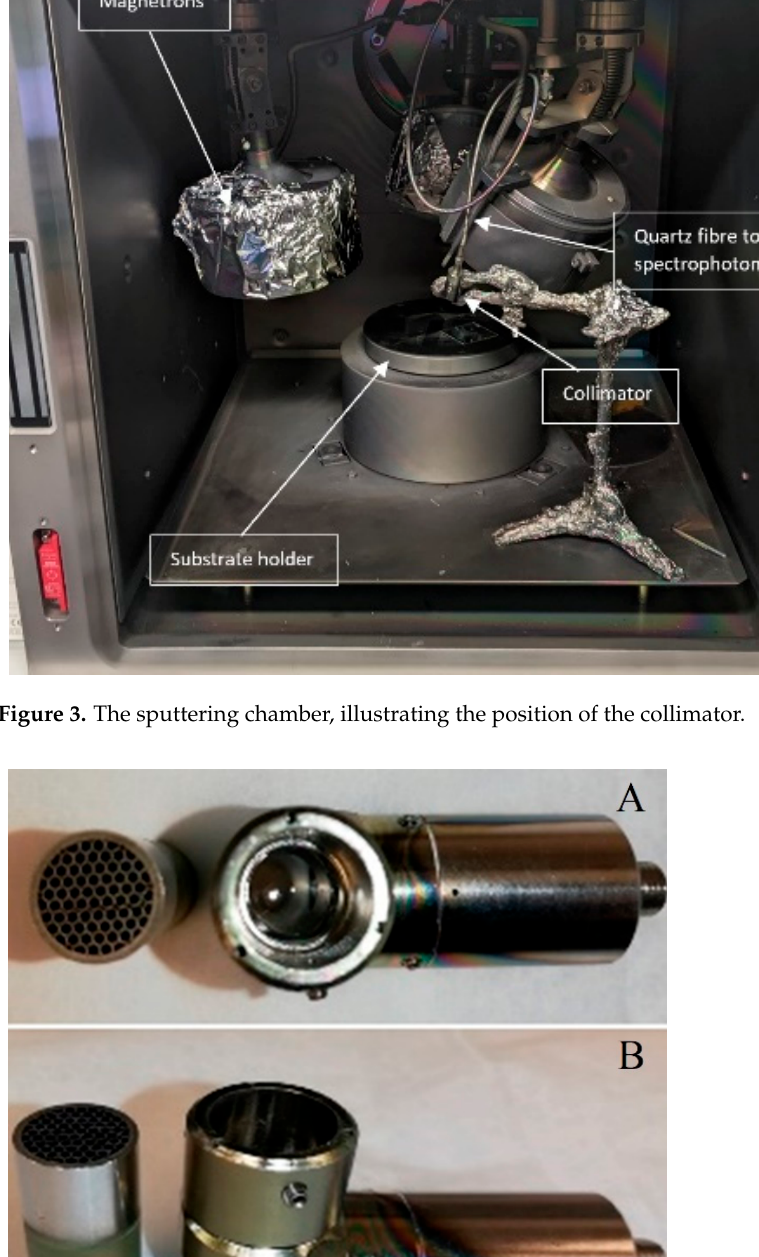
Figure 4. The collimator is fitted with a cylindrical honeycomb filter that prevents coating of the collimator lens. ( A ): Top view, showing the honeycomb lens protector. ( B ): Side view. The spectral data from the plasma were collected by fitting seven different targets in the magnetron and collecting spectral data under varying plasma powers and gas-flow rates, as depicted in Figure 5.